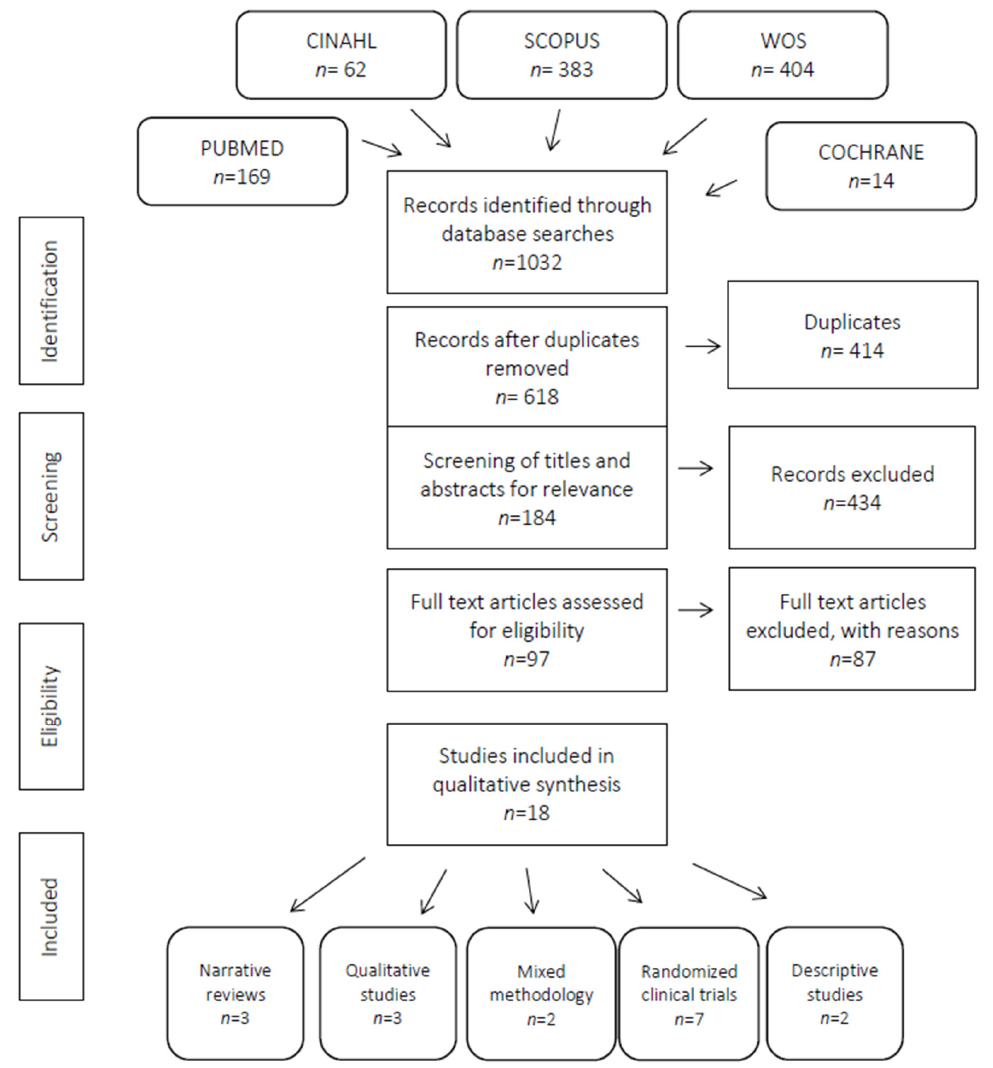
Figure 1. PRISMA flow-diagram of screening process for review.